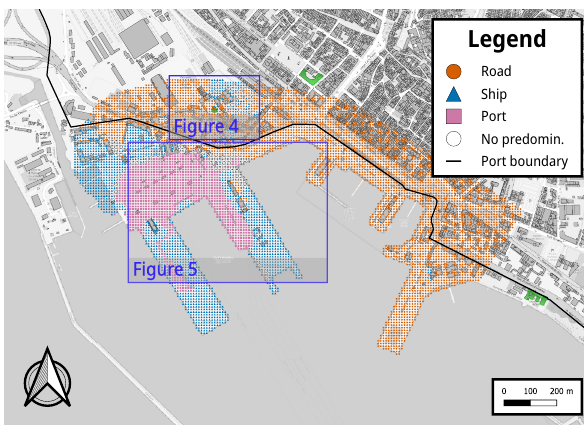
Figure 2: Noise Source Predominance map of the port of Cagliari for L DEN